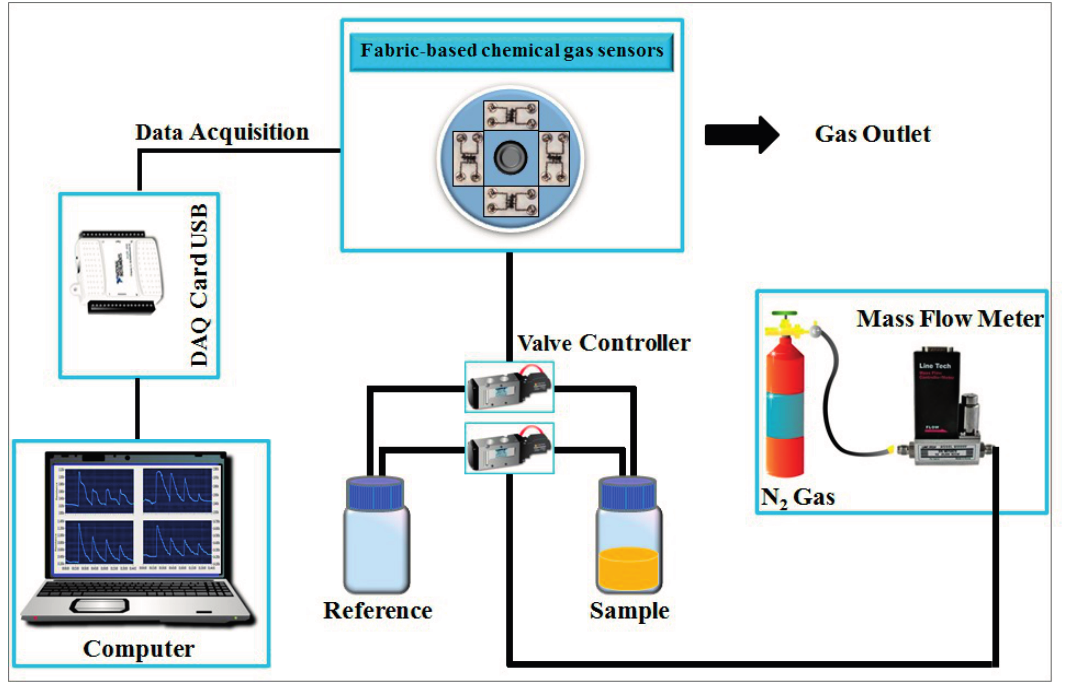
Figure 5. Schematic diagram of the fabric-based e-nose system.